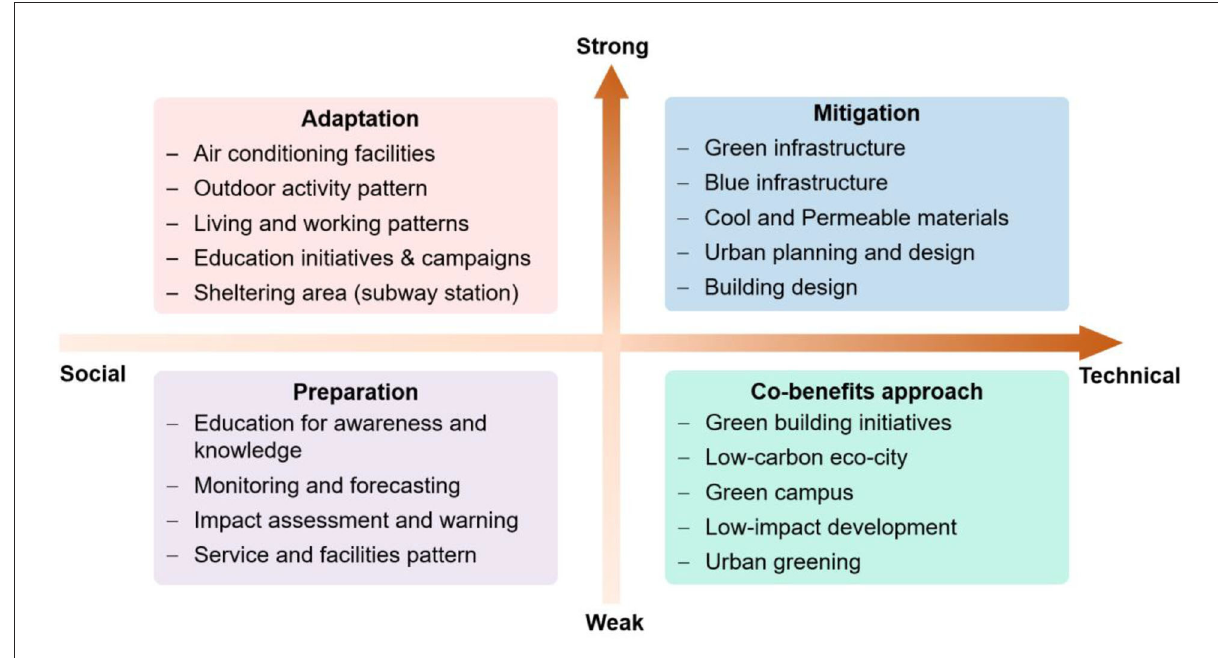
FIGURE1 Social-technical solutions to urban heat challenges